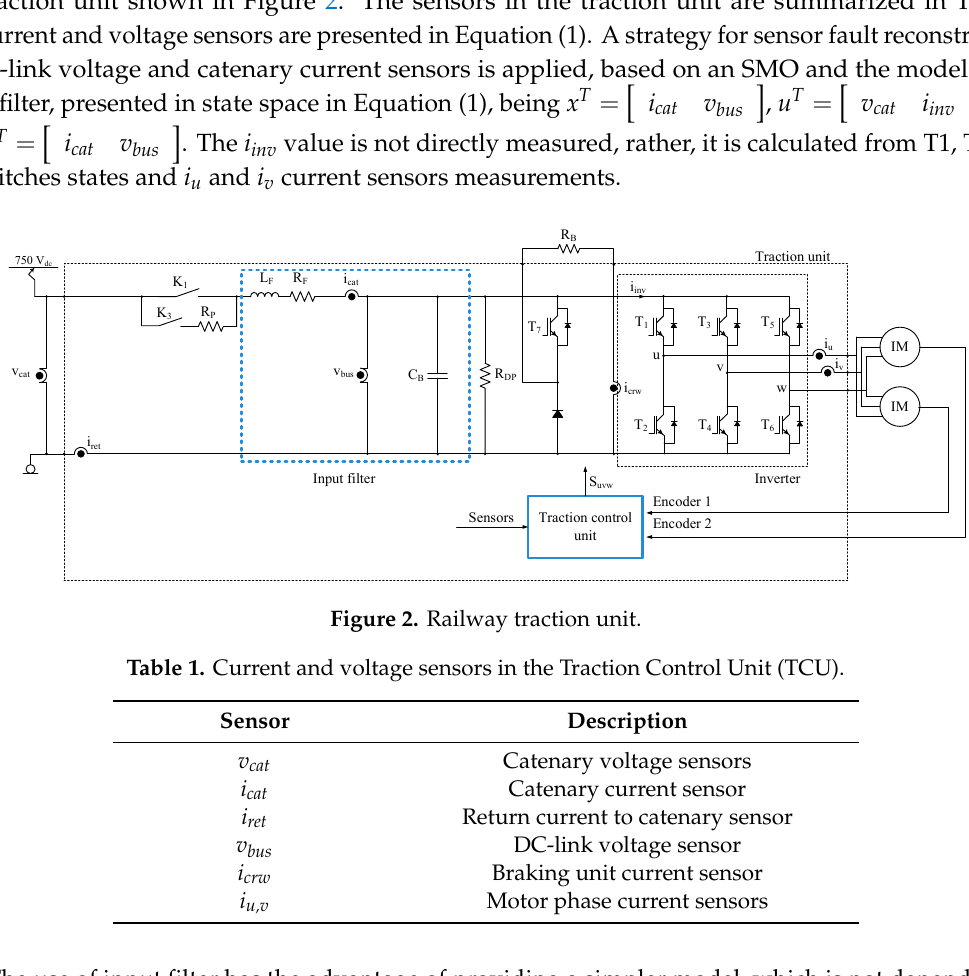
Table 1 . Current and voltage sensors in the Traction Control Unit (TCU).